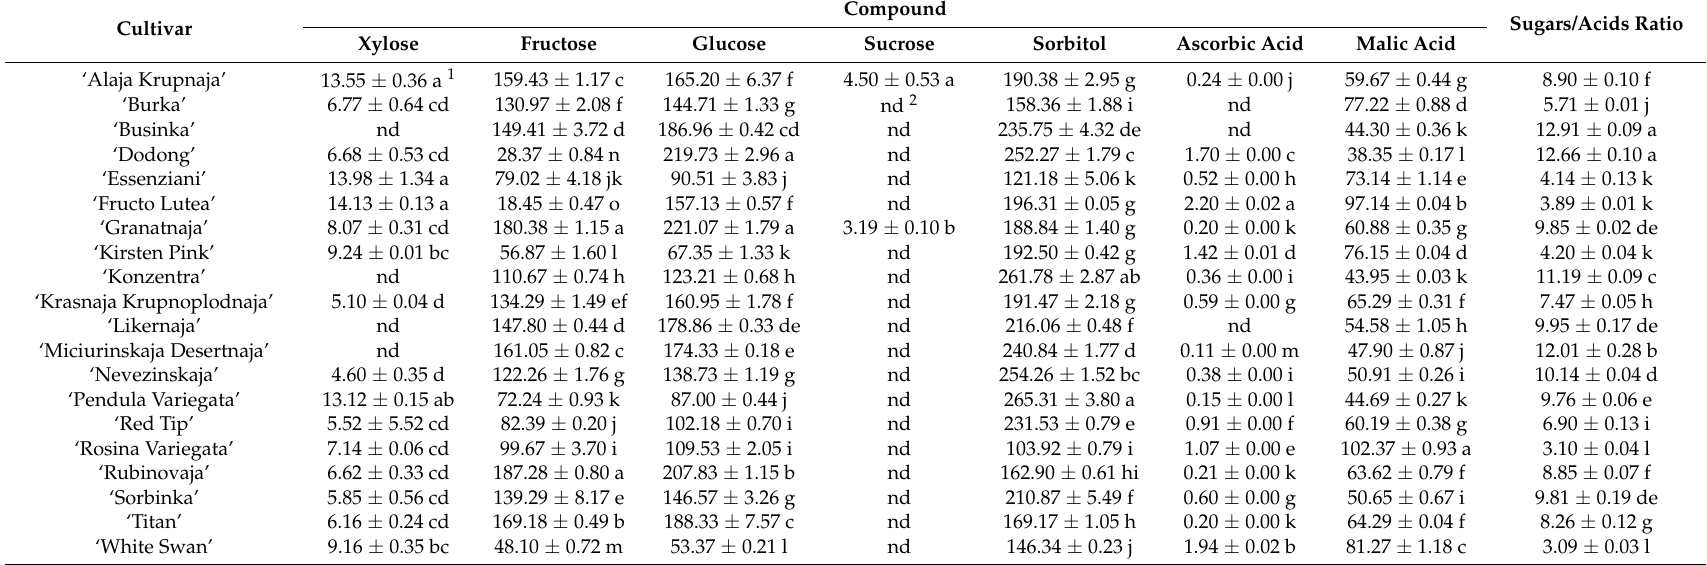
Table 4. Contents of sugars and organic acids (mg/g DW) in Sorbus fruit powder